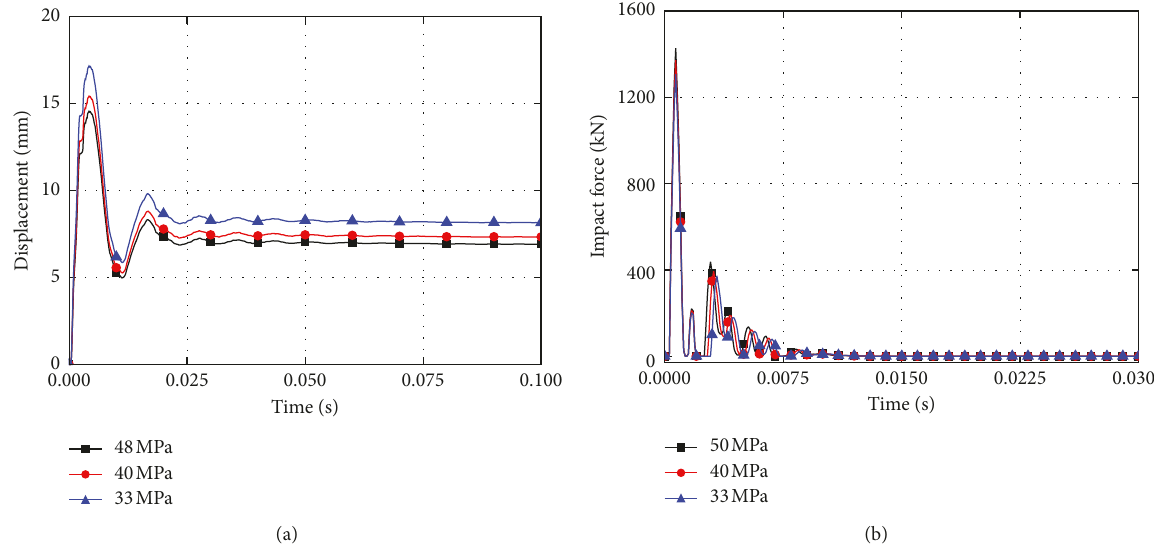
Figure 10: Comparison of impact response of different concrete strengths. (a) Comparison of midspan displacement. (b) Comparison of impact force.